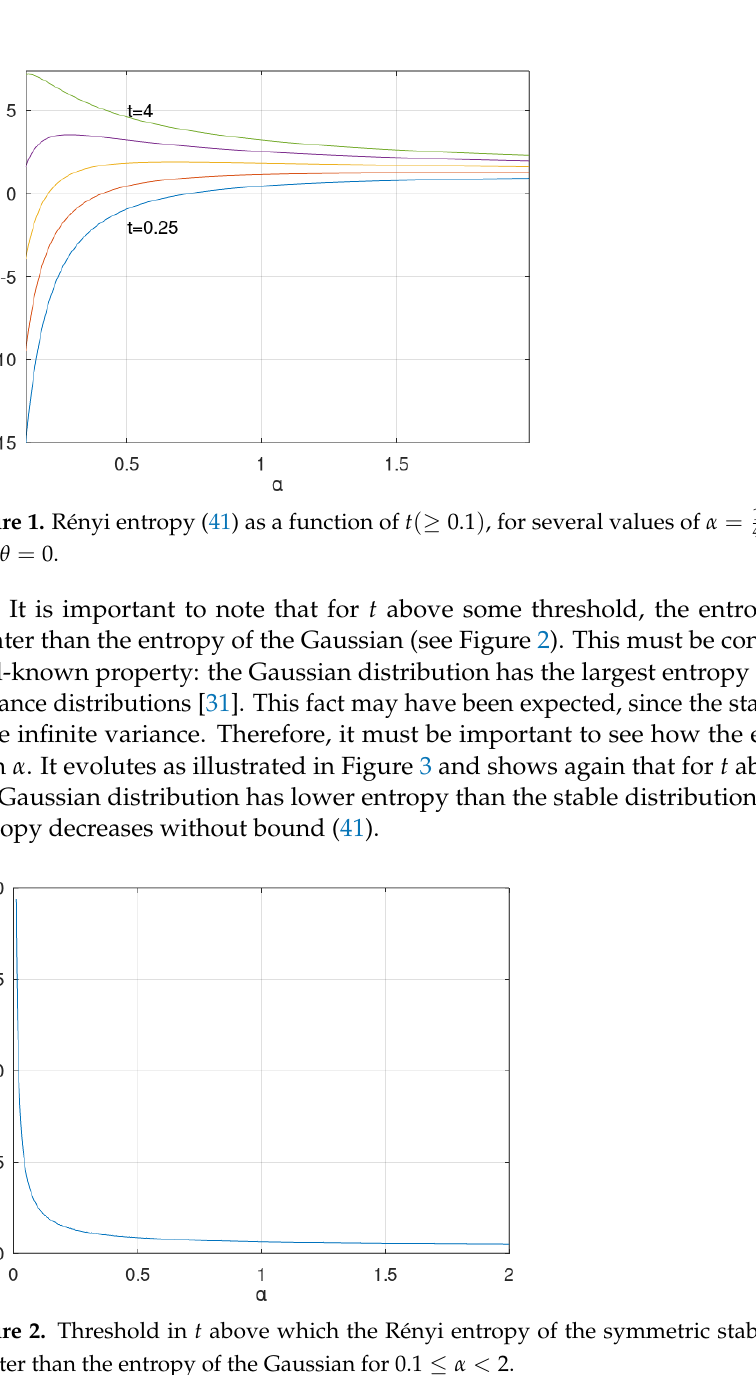
Figure 2. Threshold in t above which the Rényi entropy of the symmetric stable distributions is greater than the entropy of the Gaussian for 0.1 ≤ α <